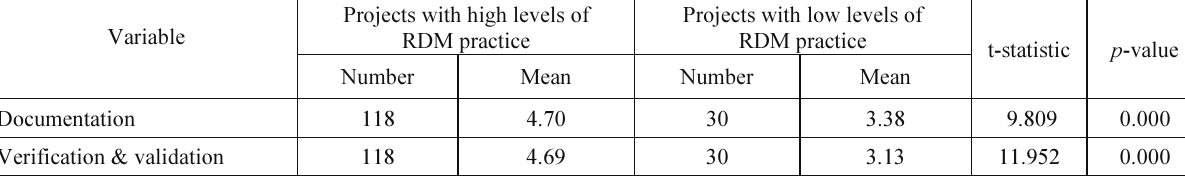
Table 5. Cluster means of discriminating